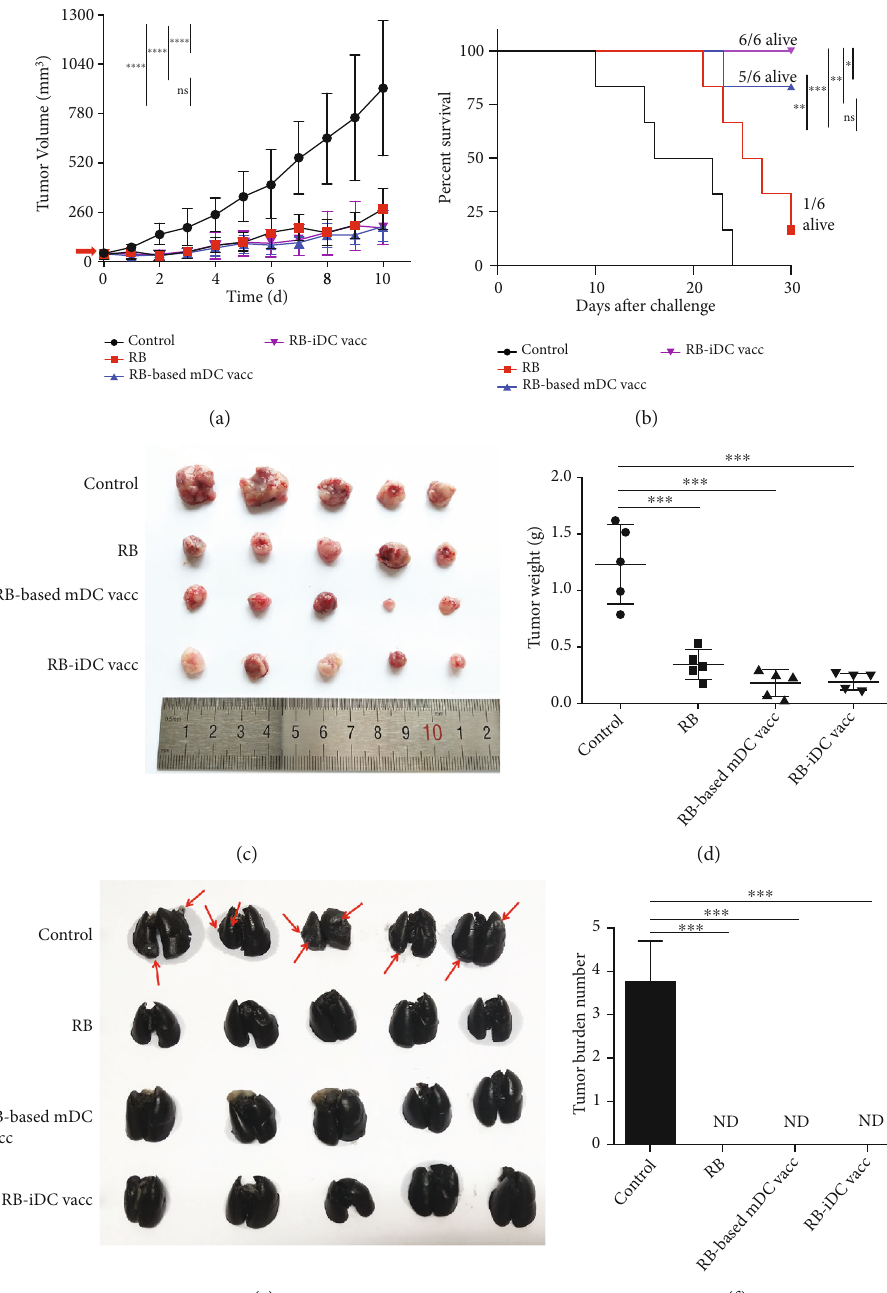
Figure 5: The antitumour e ff ects of the RB, RB-based mDC vaccine, and RB-iDC vaccine treatments. (a) LLC tumours were grown to approximately 1300 mm 3 in the groups, with 5 animals per condition. The graphs describe the tumour growth kinetics of the control animals treated with PBS and the animals receiving the three designated treatments, as indicated by the label in the upper right-hand corner of each graph. All animals received RB by intralesional injection; the mice of the RB-based mDC vaccine-treated group received 1 × 10 6 bone marrow-derived mature DCs pulsed with RB-treated LLC lysis, and the RB-iDC vaccine-treated group underwent RB injection and then received 1 × 10 6 bone marrow-derived iDCs 10 min later by intralesional injection. Each group received only one treatment. All animals received RB, the RB-based mDC vaccine, or the RB-iDC vaccine on day 0. (b) Mouse survival is shown as a Kaplan – Meier curve ( n = 6 /group). Signi fi cant di ff erences in survival were observed between the RB-iDC vaccine group and the other three groups. (c) The tumours were removed from all the mice of the four groups and photographed. (d) LLC tumour weight comparisons among the four groups were performed on day 30 after the tumour challenge. (e) Representative lungs from the treated mice are shown. (f) Dots represent the mean number ± SD of lung metastasis lesions. ND: not detected. The data represent three independent experiments. Signi fi cance between samples was evaluated by one-way ANOVA (ns: not statistically signi fi cant, ∗ P < 0 : 05 , ∗∗ P < 0 : 01 , ∗∗∗ P < 0 : 001 , ∗∗∗∗ P < 0 : 0001